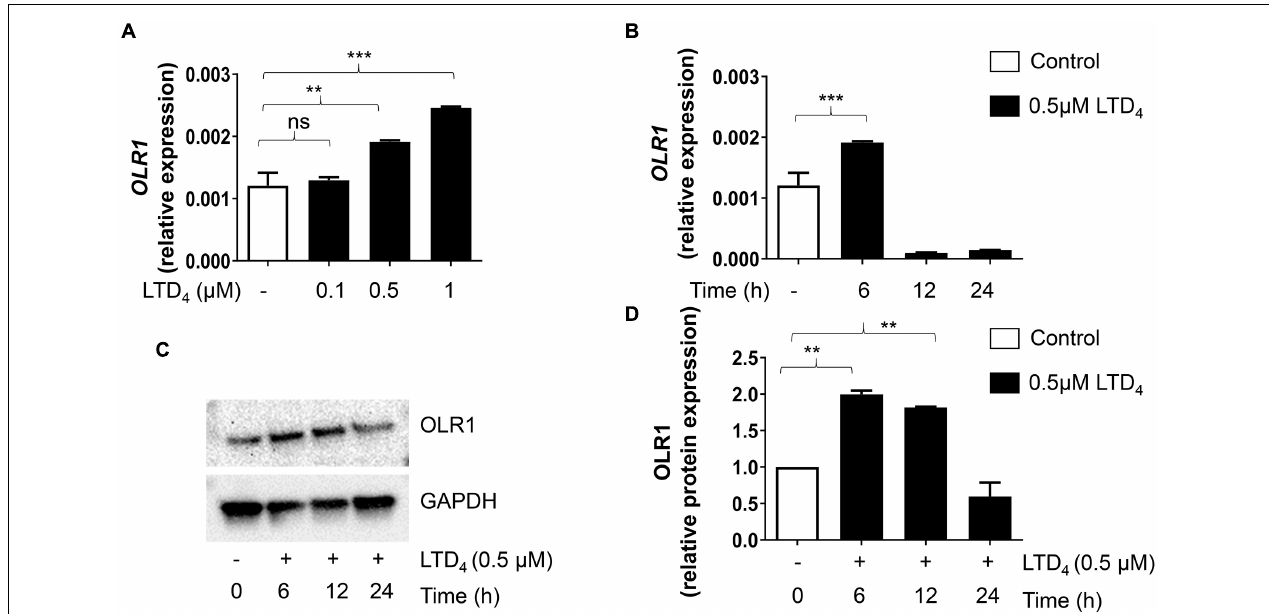
FIGURE 4 | Cys-LTs induce upregulation of OLR1 transcript and protein. Raw macrophages were treated with increasing concentrations of LTD 4 for 6, 12, and 24 h, and the expressions of OLR1 transcript (A,B) was analyzed using qPCR and protein expression was analyzed by Western blotting (C,D) . The results shown are mean ± SEM from three separate experiments (one-way ANOVA followed by post hoc Tukey multiple comparison test, ** p ≤ 0.01, *** p ≤ 0.001, ns = not